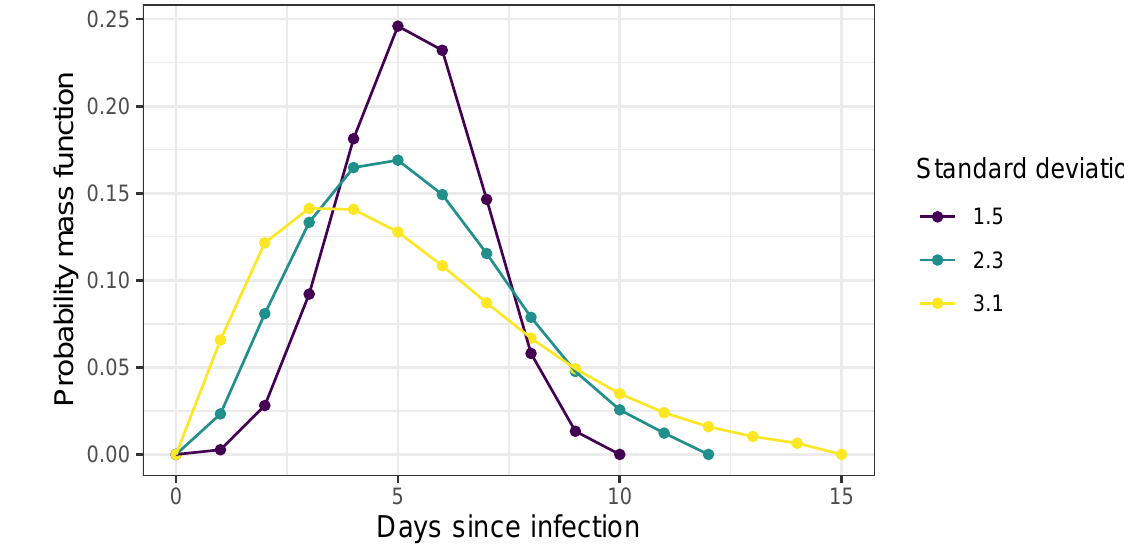
Figure S4 – Probability mass function for Weibull distributions with mean 4.8 and vari- ous standard deviation. Serial interval distributions used hereafter to analyze the sensi- tivity to the serial interval standard deviation.